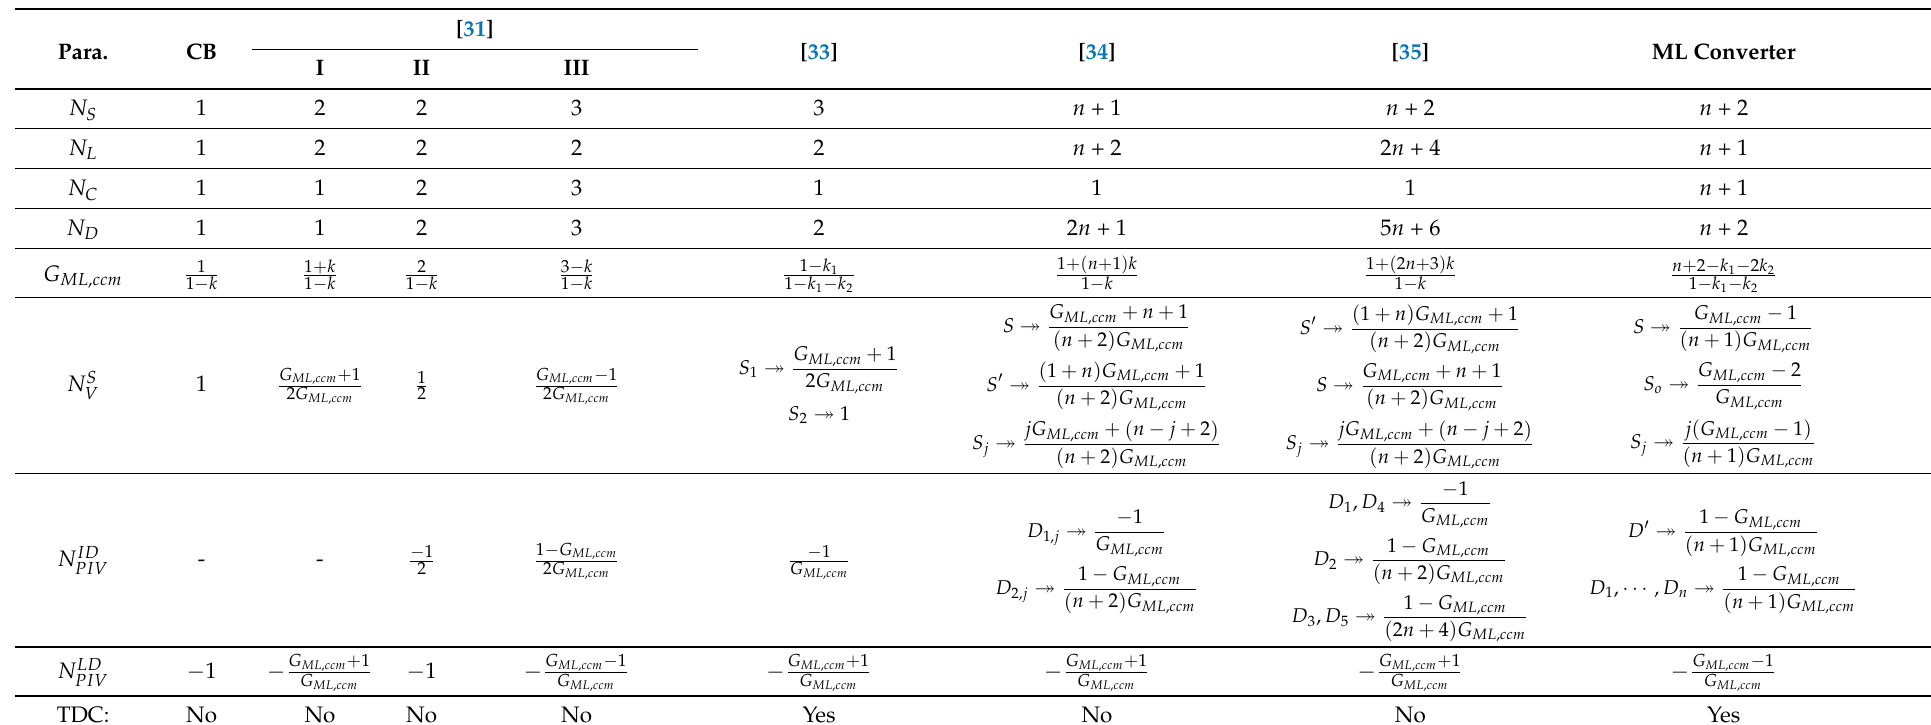
Table 1. Comparison of